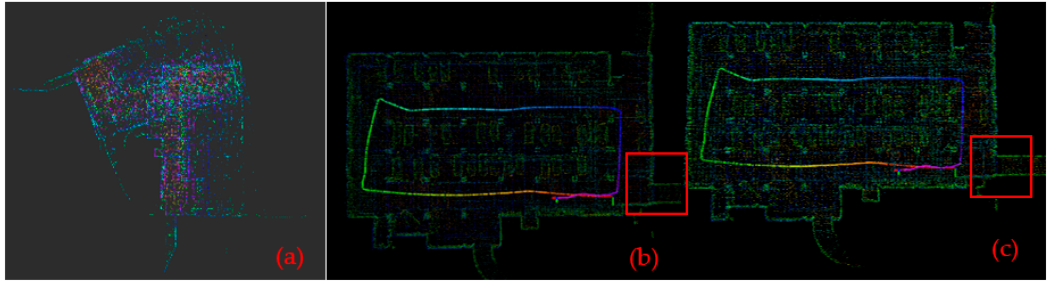
Figure 11. Constructed map for scene #1. ( a ) By LOAM; ( b ) by LeGO-LOAM; ( c ) by LeGO-LOAM-SC.